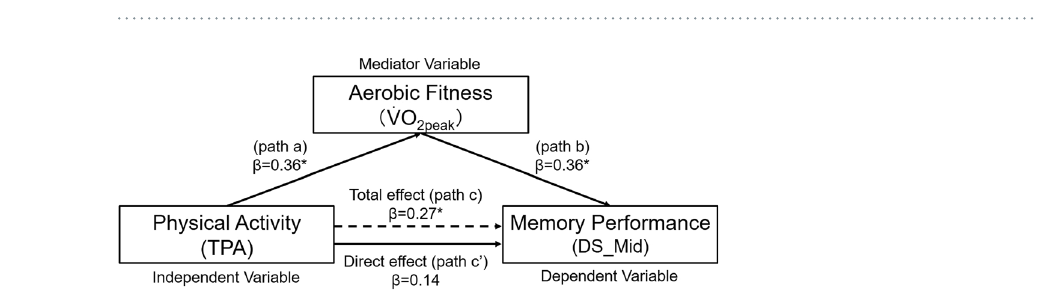
Figure 3. ( a ) Relationship between aerobic fitness (  V O 2peak ) and discrimination score for middle-similarity bins (DS_Mid). ( b ) Relationship between physical activity and discrimination score for middle-similarity bins. ( c ) Relationship between physical activity and aerobic fitness (  V O 2peak ). Discrimination score = 1 − p(“old”|Lure), pr = partial correlation coefficient after controlling for sex. * p < 0.05.